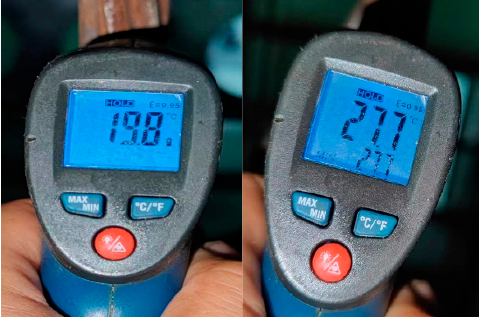
Figure 11. Temperature measurement process before and after impact. Table 4. The temperature variation data of cables.